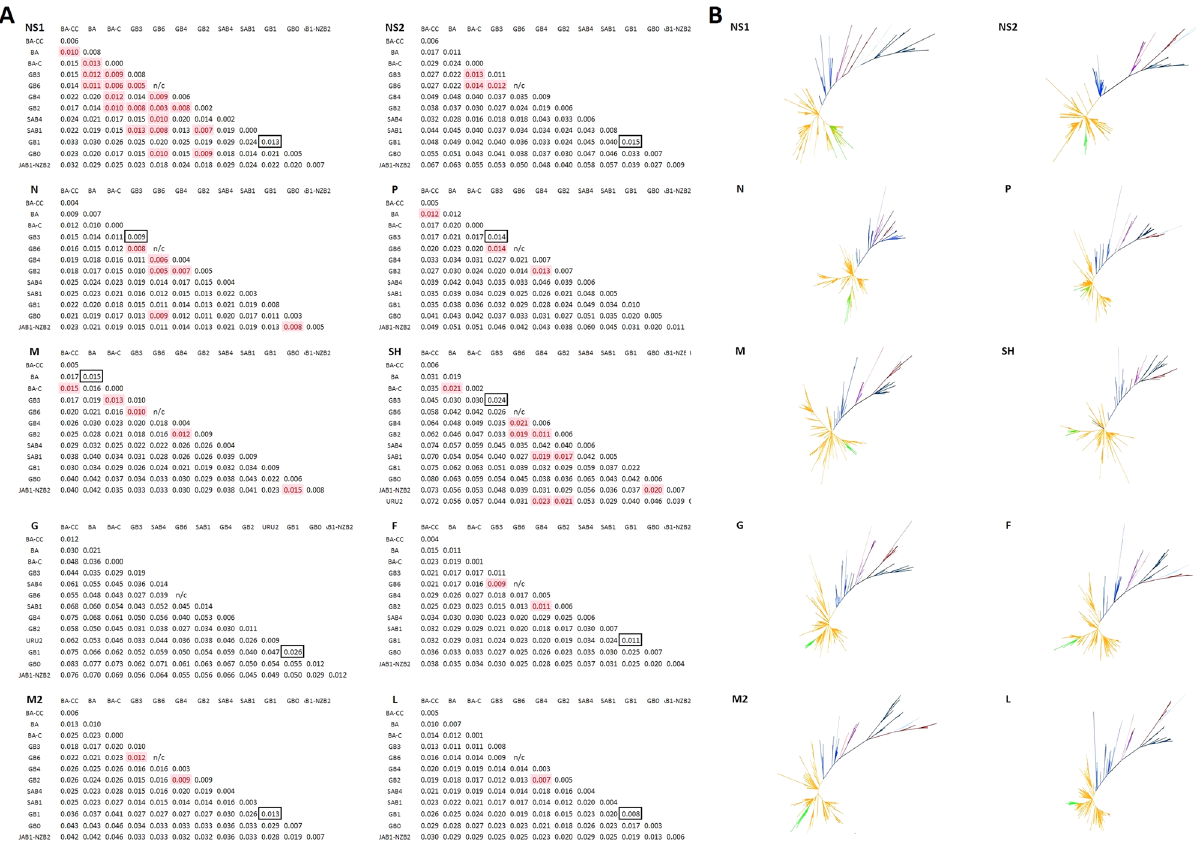
Figure 4. ( A ) Intergenotypic and intragenotypic p-distance analysis of complete NS1, NS2, N, P, M, SH, G, F, M2, and L genes of RSV-B sequences. ( B ) Unrooted phylogenetic tree of complete NS1, NS2, N, P, M, SH, G, F, M2, and L genes of RSV-B sequences constructed Maximum Likelihood analysis.